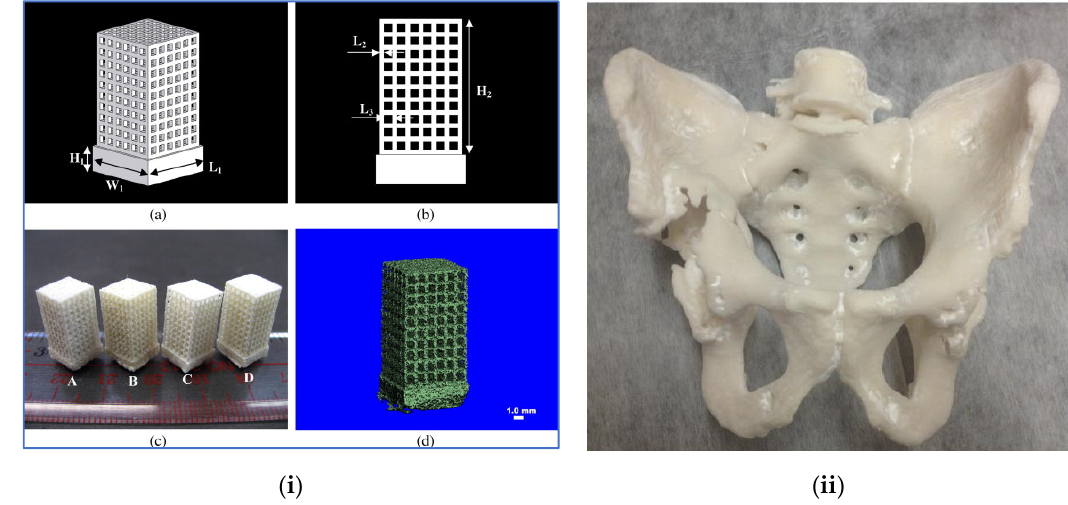
Figure 5. ( i ) ( a ) Schematic diagram of scaffold model PHBV (diametric view), ( b ) scaffold model (Side view), ( c ) scaffold models from Selective Laser Sintering (SLS): ( A ) PHBV, ( B ) CaP/PHBV, ( C ) PLLA, ( D ) CHAp/PLLA. ( d ) MicroCT image of a CaP/PHBV scaffold [47]. ( ii ) A life ‐ size 3D printed model